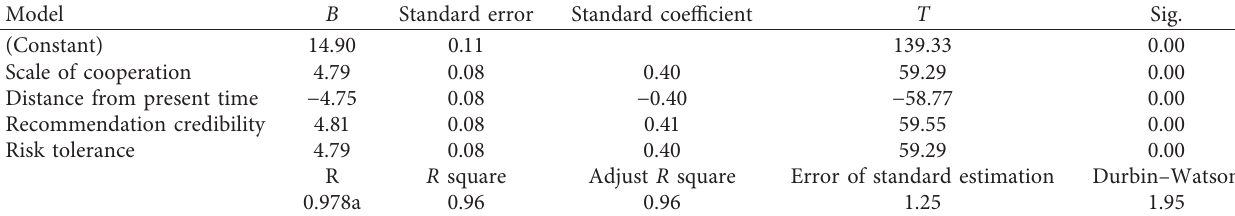
Table 6: Regression analysis